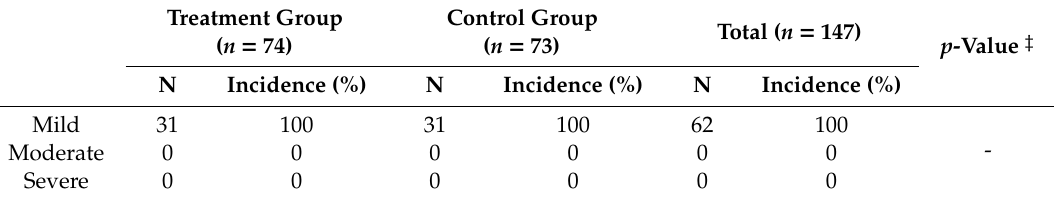
Table 5. Abnormal events between treatment (COEC) and control (placebo) group throughout 0–12 weeks